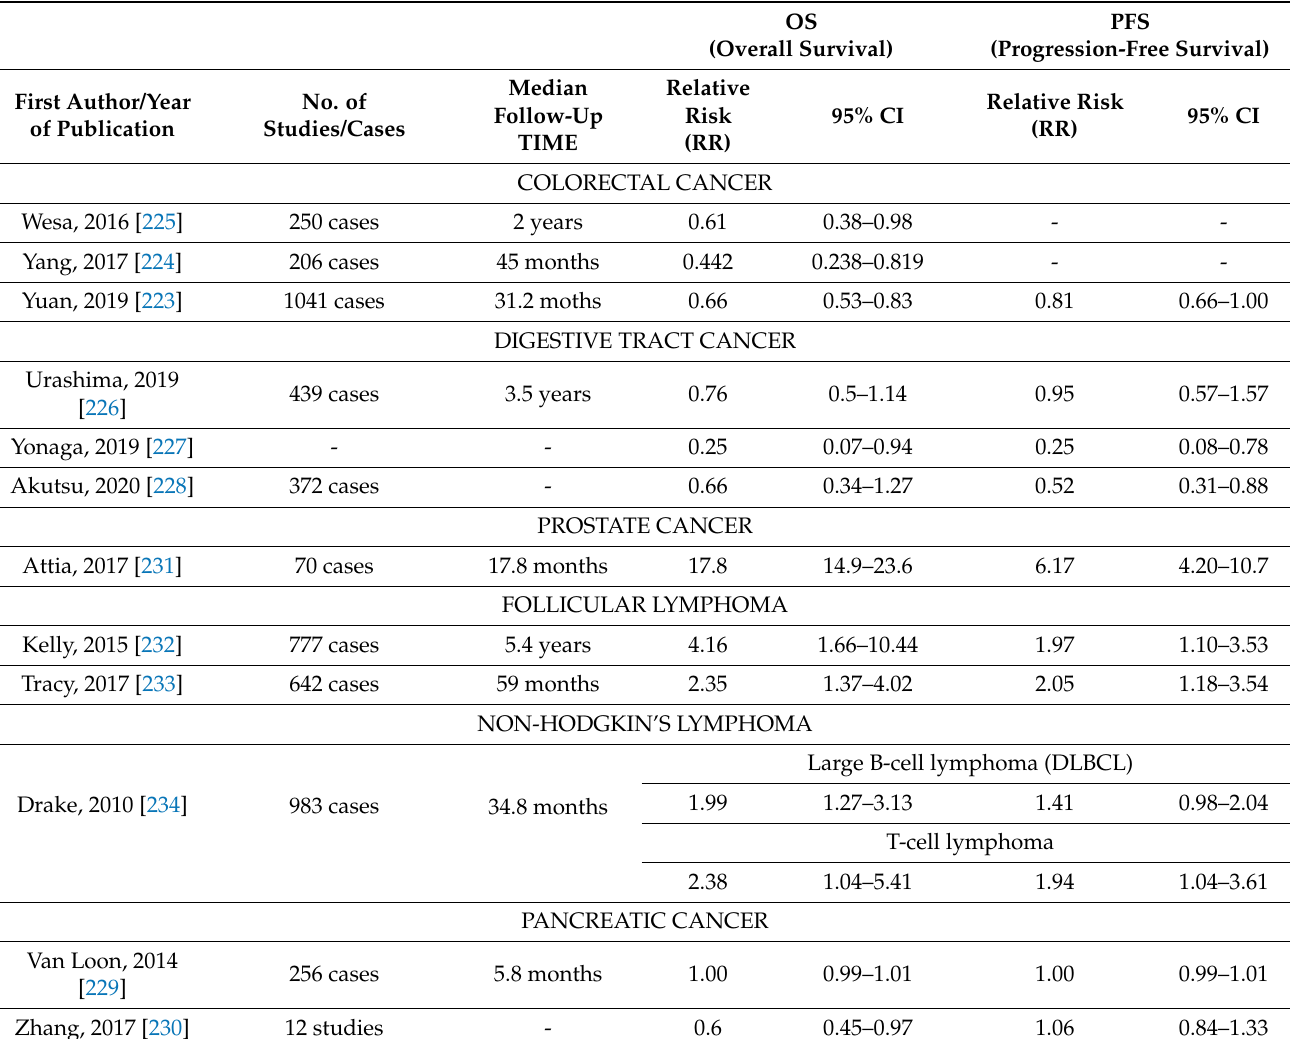
Table 2. The effect of 25 (OH) D on the OS and PFS in various types of cancer.